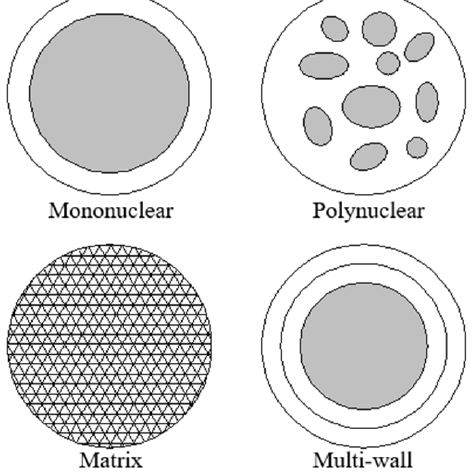
Figure 6. Microcapsule types, Jamekhorshid [112].